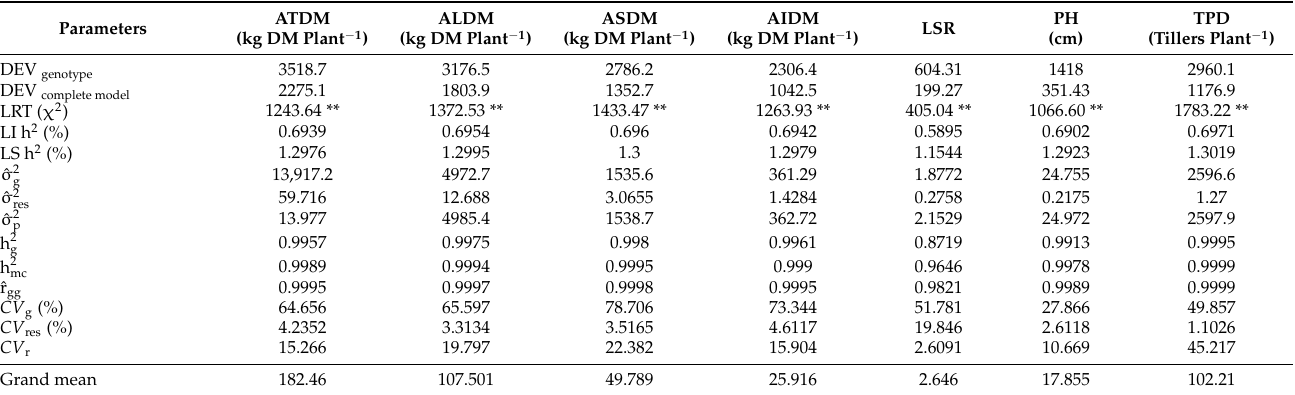
Table 2. Verisimilitude values (LRT) of deviance analysis (ANADEV) and estimates of genetic parameters (individual REML) for characteristics quantified for intraspecific hybrids of P. notatum